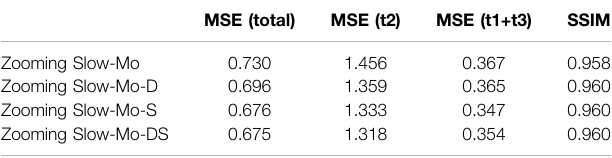
TABLE 2 | Test set evaluation